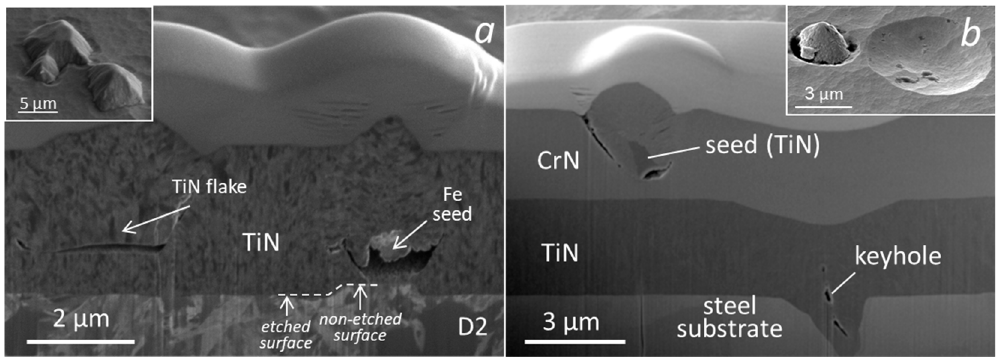
Figure 20. Typical growth defects in TiN ( a ) and TiN / CrN double layer ( b ) hard coatings prepared by thermionic arc evaporation. FIB images show the origin of defects.